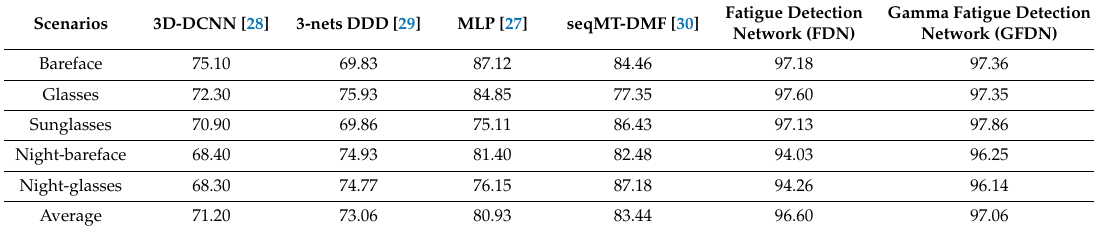
Table 1. Drowsiness detection accuracies (%) for di ff erent scenarios of the NTHU-DDD dataset. Scenarios